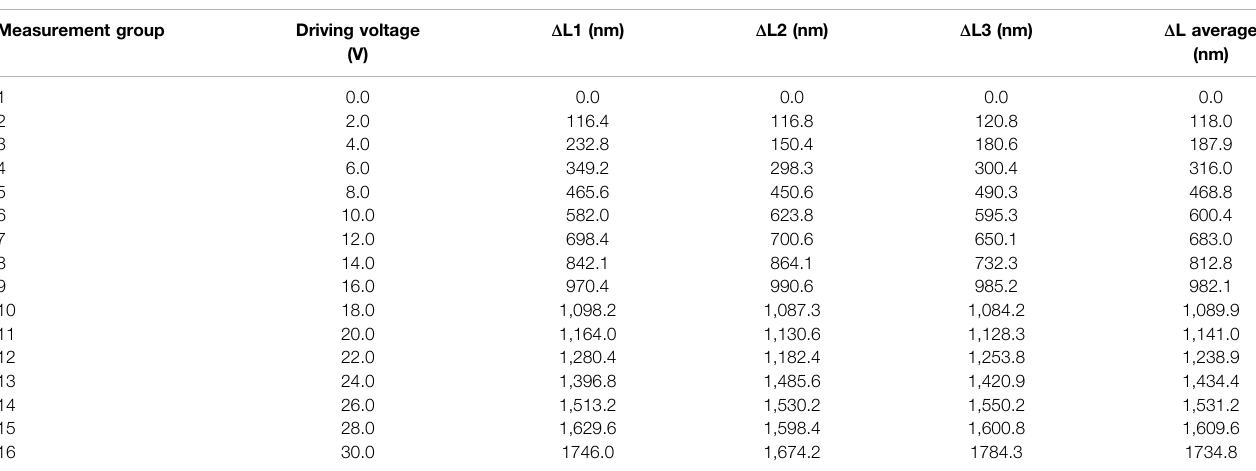
TABLE 1 | Measurement results of the movement of the mirror M2. Measurement